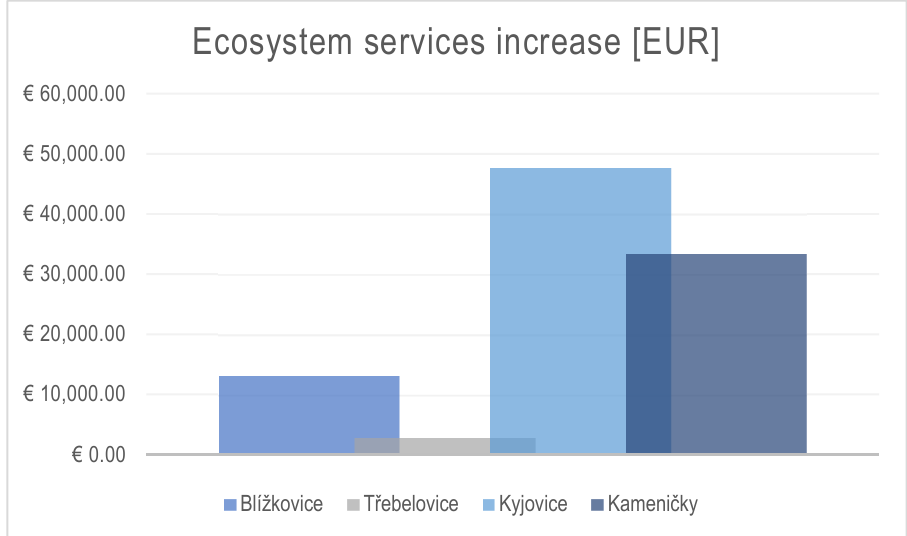
Figure 3. Absolute expected ecosystem services increase within research localities.